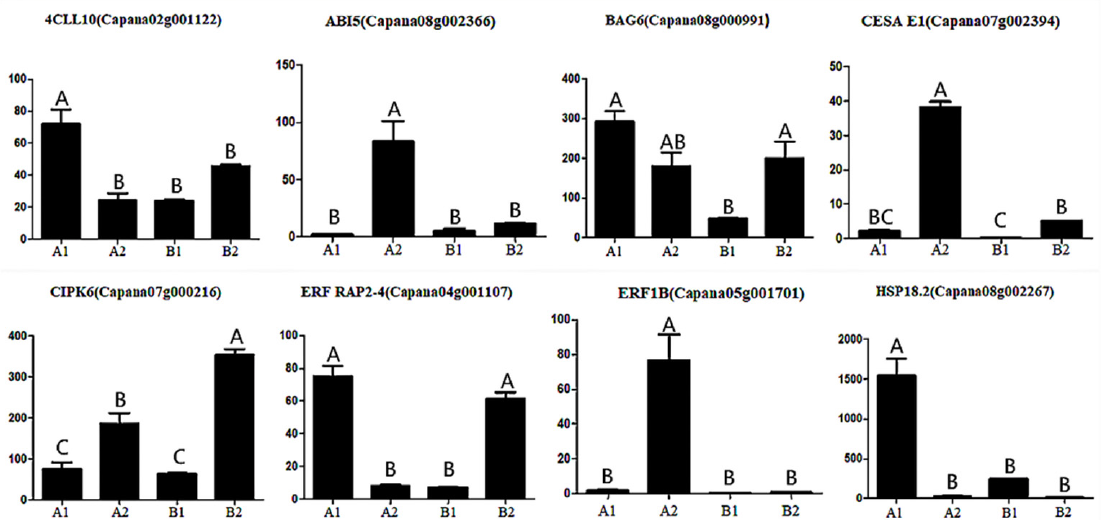
Figure 11. Expression analysis of 8 genes in pepper during different storage periods. Annotation: The horizontal coordinate represents different groups, and the ordinate represents the gene expression. Different letters above the bar chart indicate significant differences ( p < 0.01).